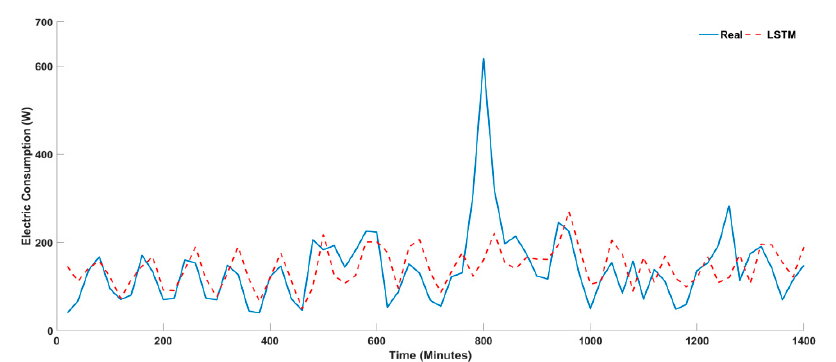
Figure 4. LSTM for univariate time series.